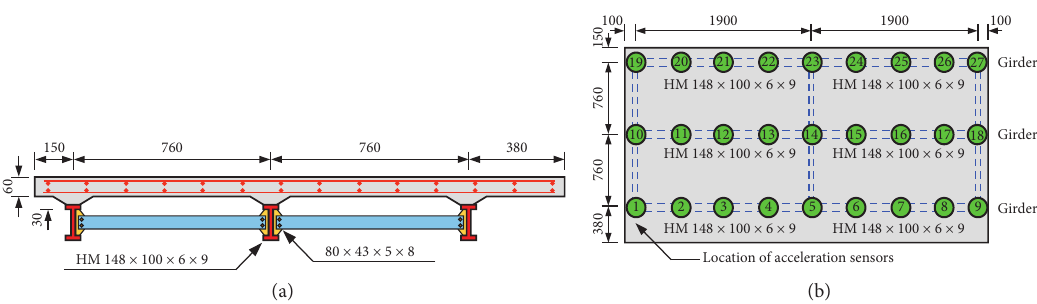
Figure 1: Steel-concrete composite slab model: (a) cross section; (b) instrumentation layout for the dynamic test (unit: mm).